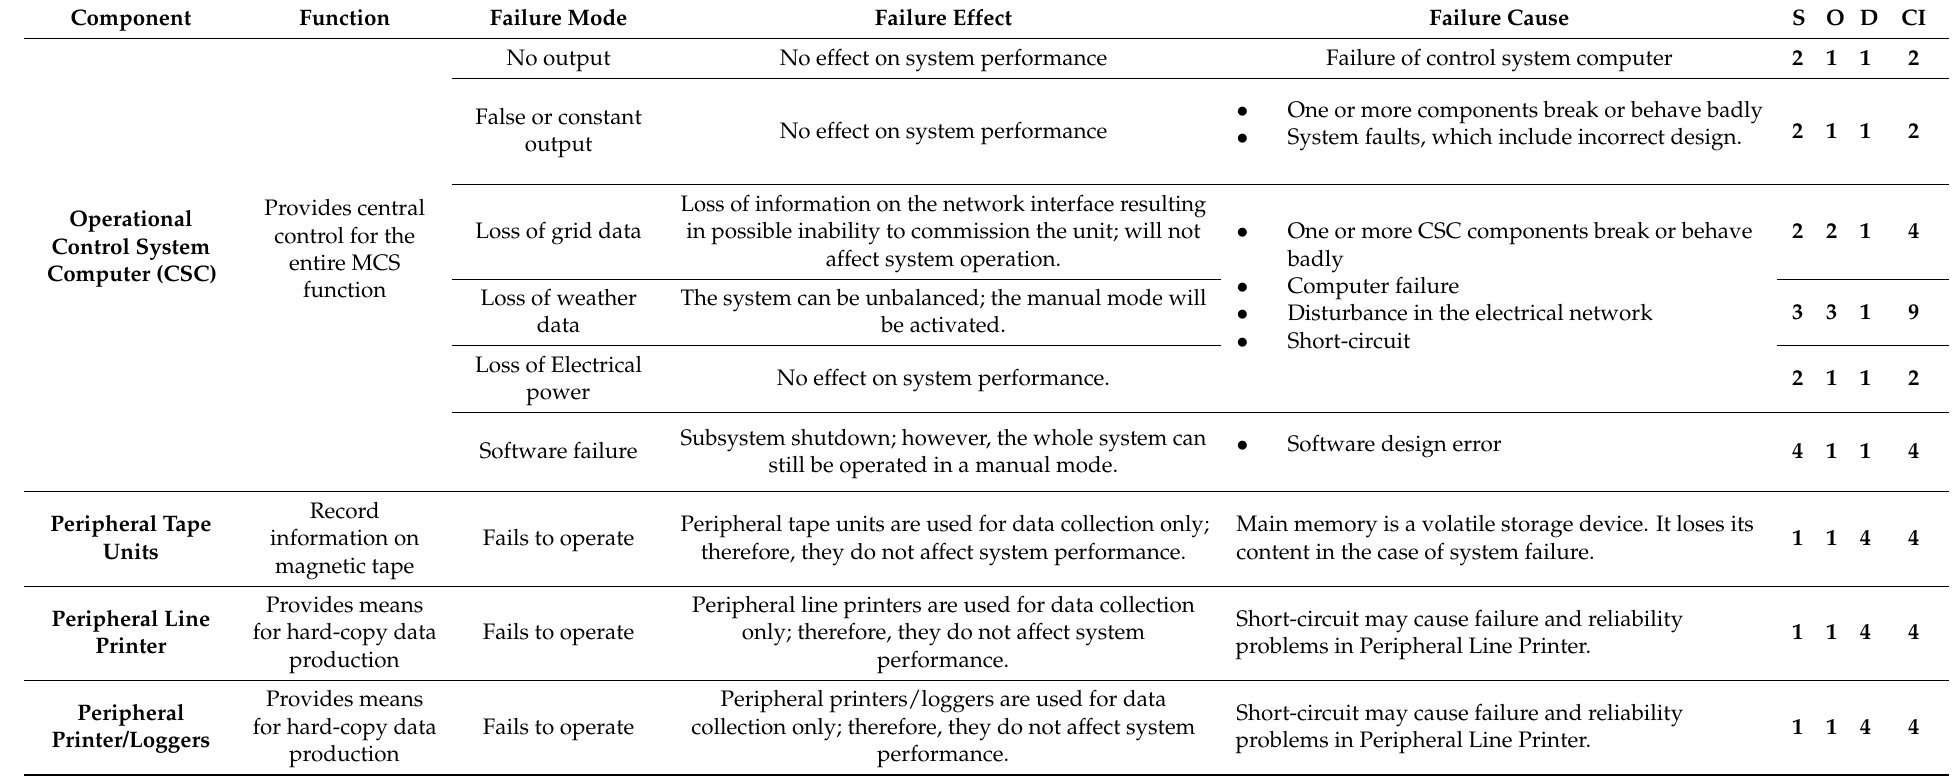
Table 5. Master Control Subsystem